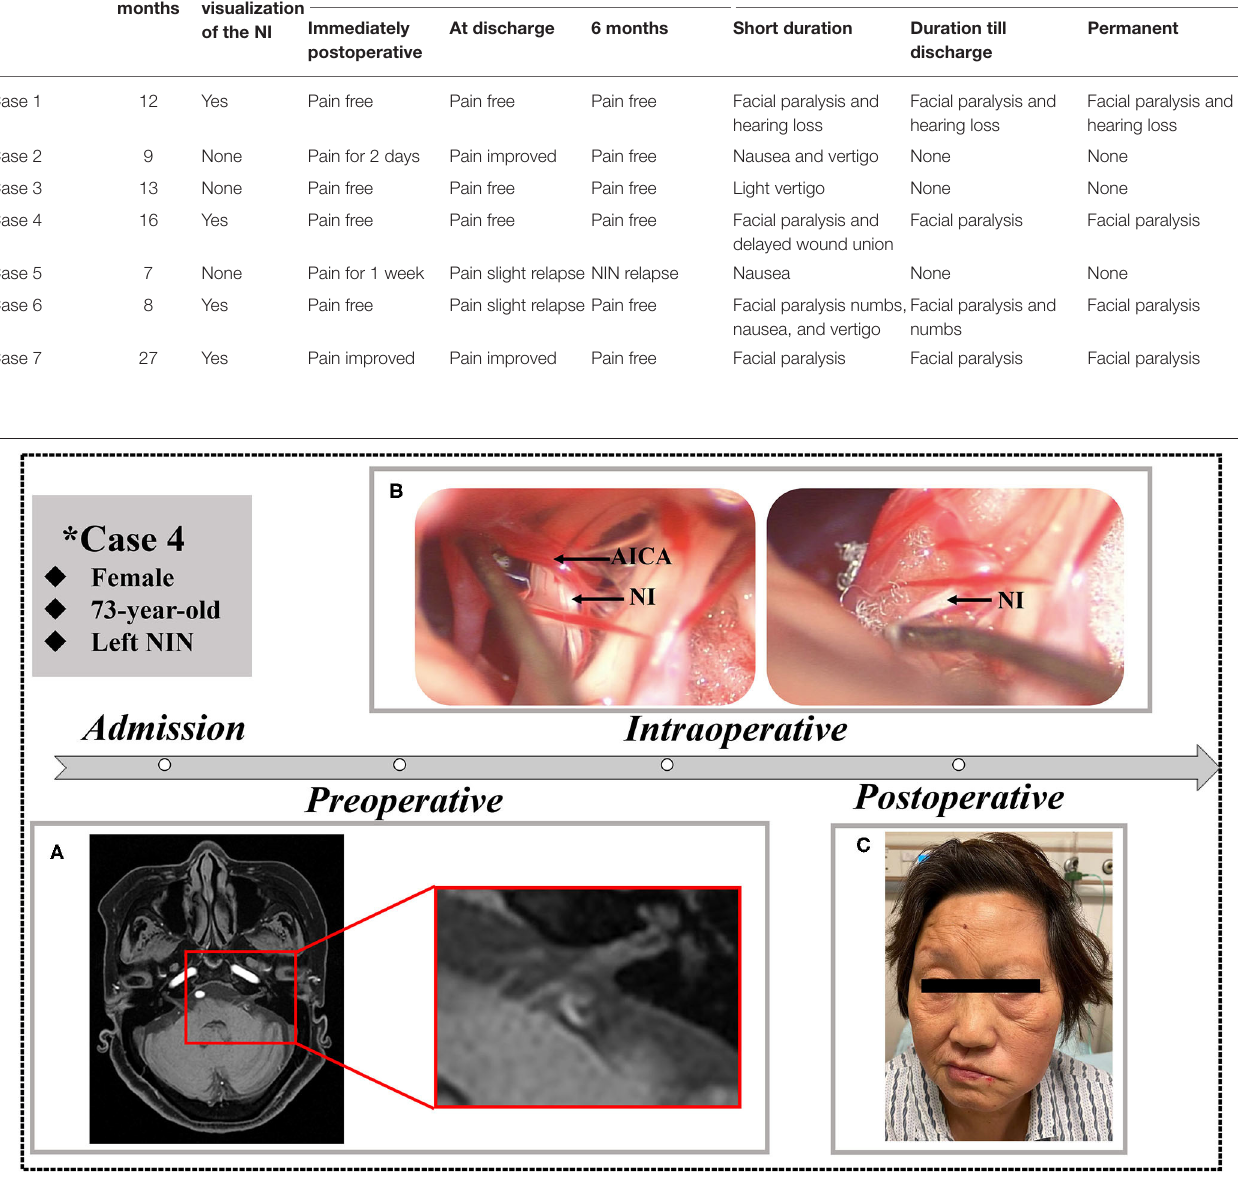
TABLE 3 | Patients’ outcomes.